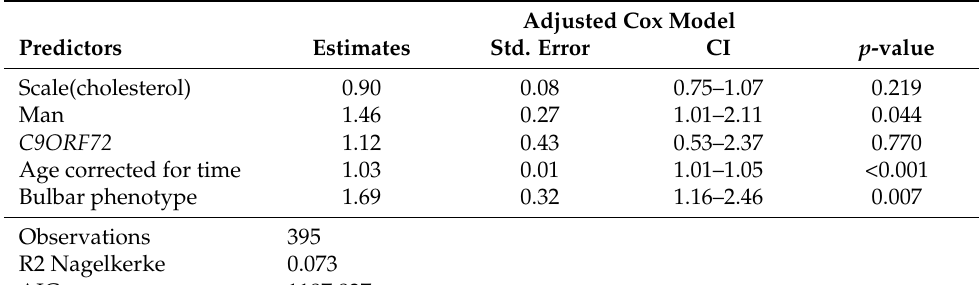
Table 5. Adjusted Cox model according to cholesterol value. The model does not allow us to conclude that for a subject alive at a determined time, if cholesterol is higher, the risk of death at any time thereafter increases. Age corrected for time refers to the time elapsed between onset and diagnosis.